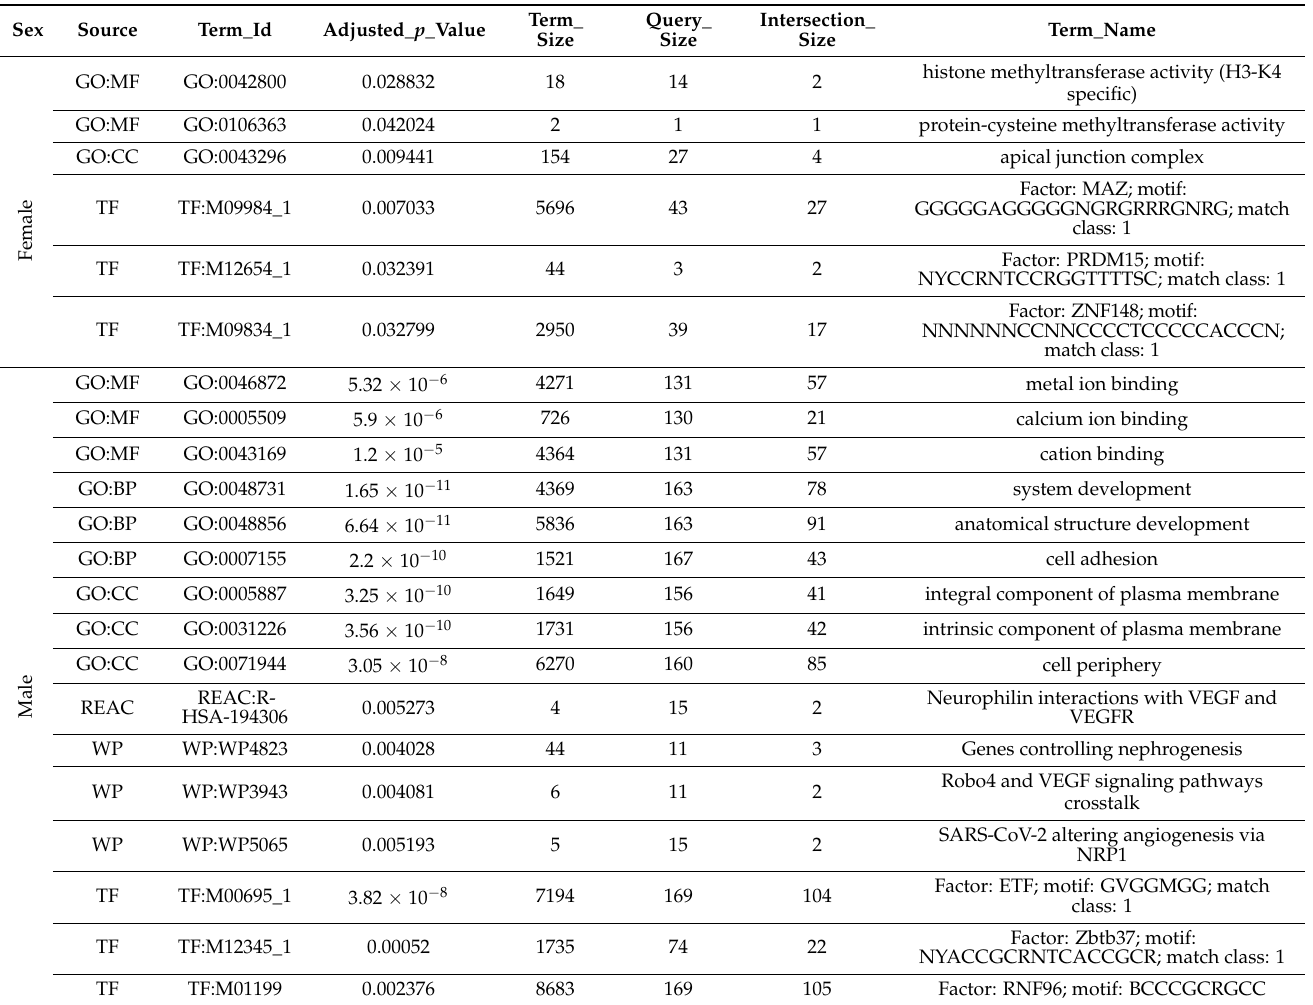
Table 6. The sex-specific AR-associated enrichment of gene function.